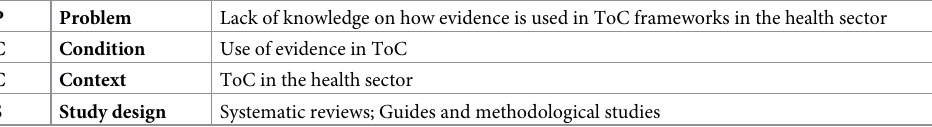
Table 1. PCCS acronym for the research